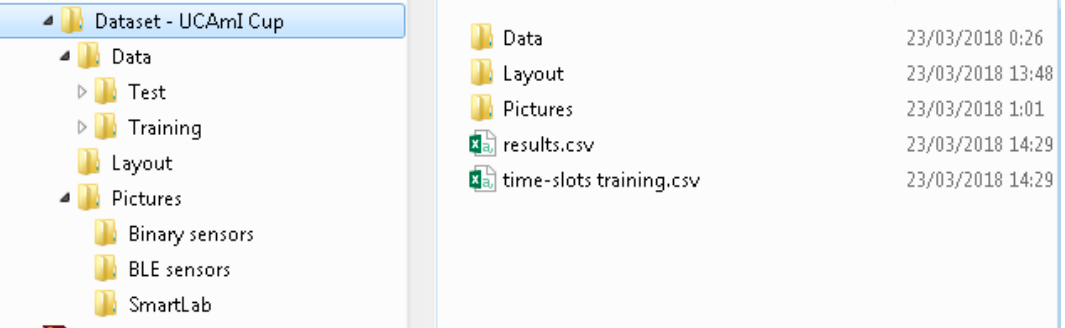
Figure 2. Folders and files in the root folder of the UJA